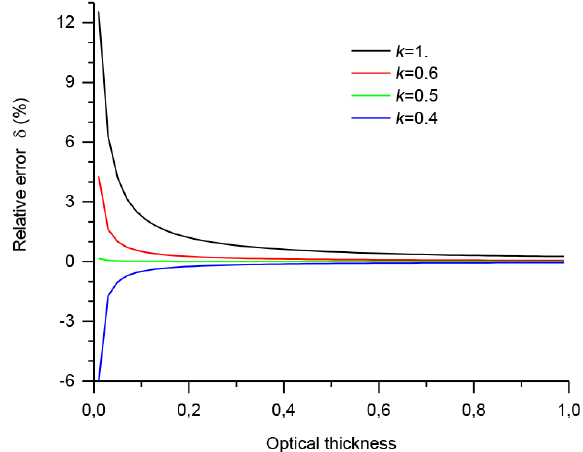
Figure B1. Relative errors as functions of the optical thickness from the layer base and the parameter k . The green line ( k = 0 . 5) and the black line ( k = 1 . 0) correspond to the cases when τ(h) is taken in the middle and at the far end, respectively, of the range